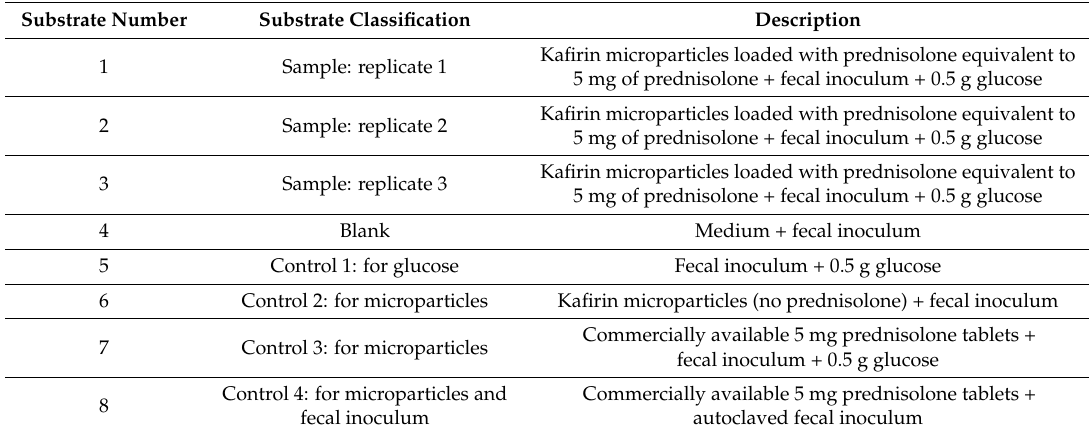
Table 2. Classification and description of the substrates used for fermentation in the simulated conditions of the